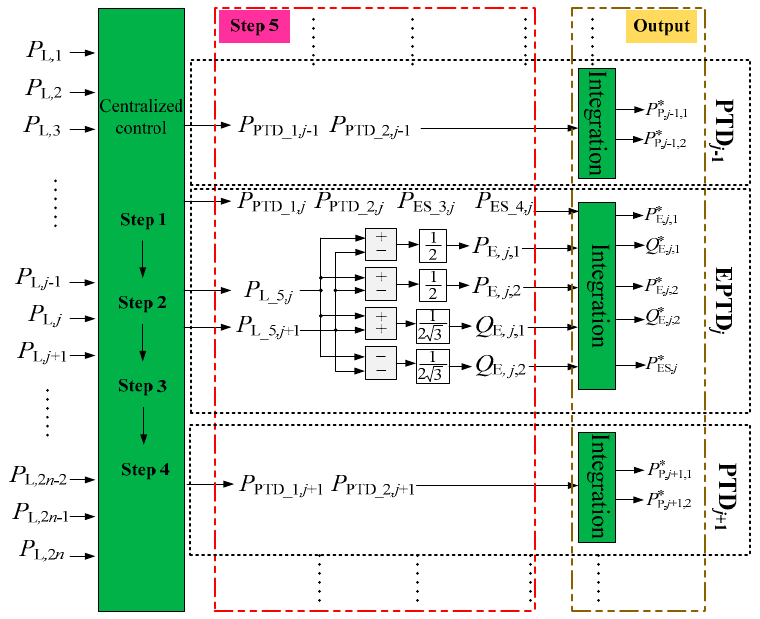
Figure 15. Calculation block diagram of regulated power reference in centralized control.